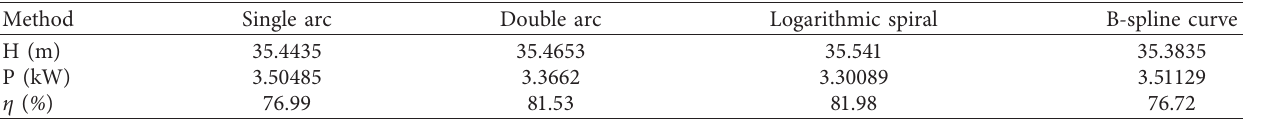
Figure 18: Vapor volume fraction distribution (NPSH � 2m). (a) Single arc. (b) Double arc. (c) Logarithmic spiral. (d) B-spline curve. r Table 8: Performance parameters comparison of four